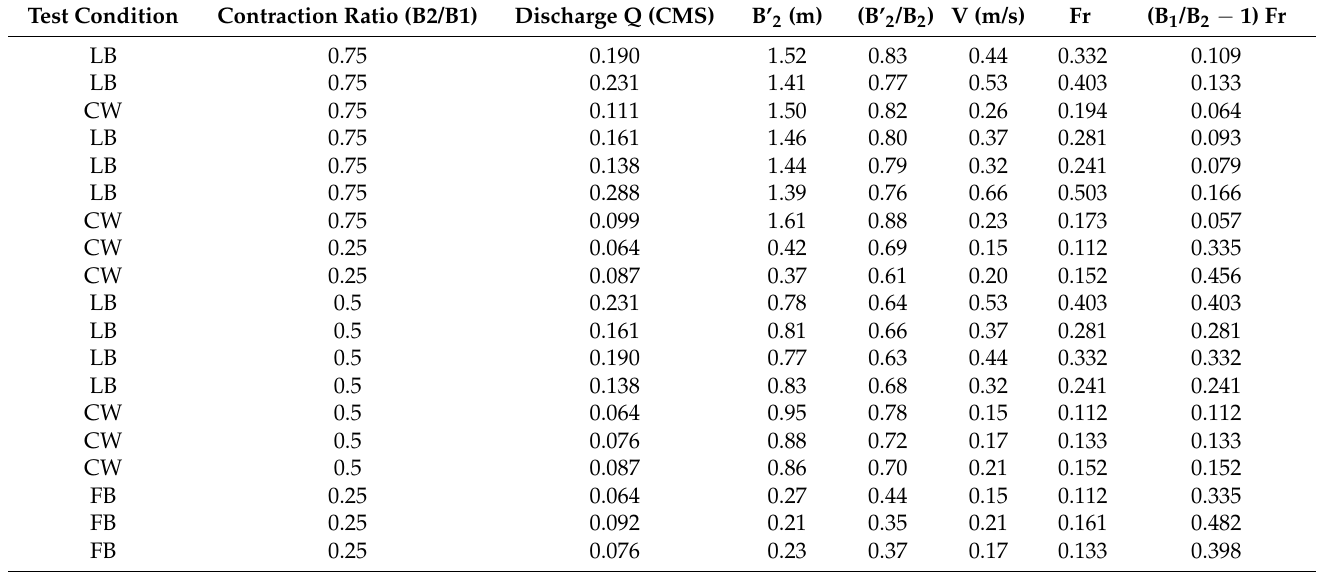
Table 3. Estimated vena contracta ratios and details for all